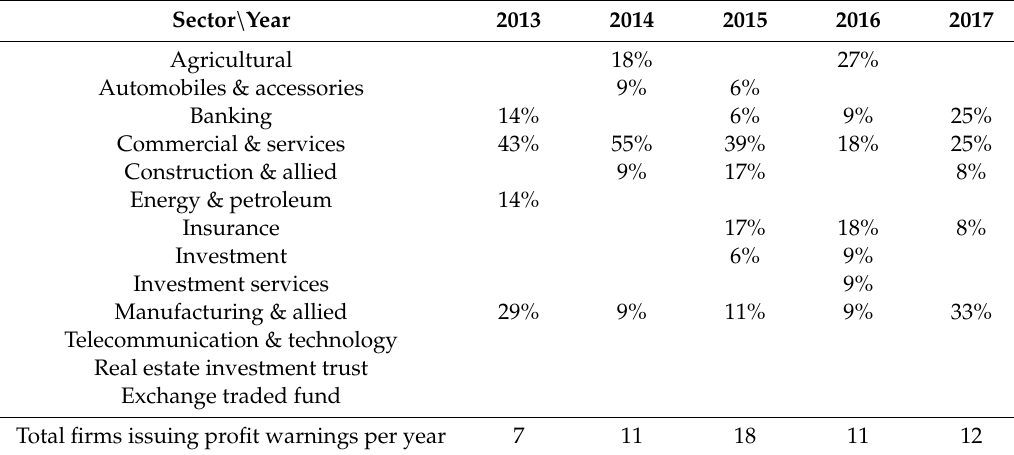
Table 1. Listed sectors that issued profit warnings from 2013 to